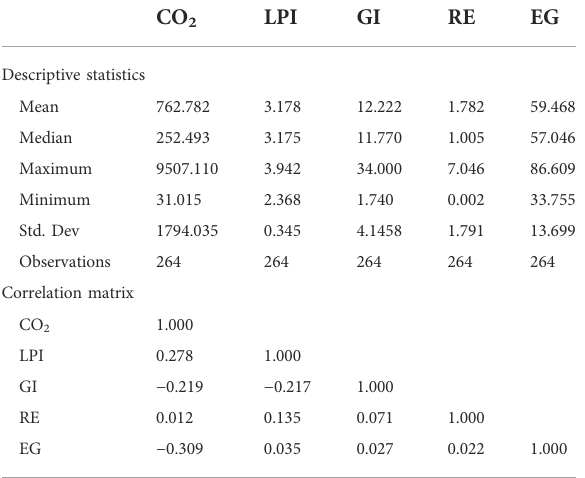
TABLE 2 Descriptive statistics and correlation matrix. TABLE 3 VIF test